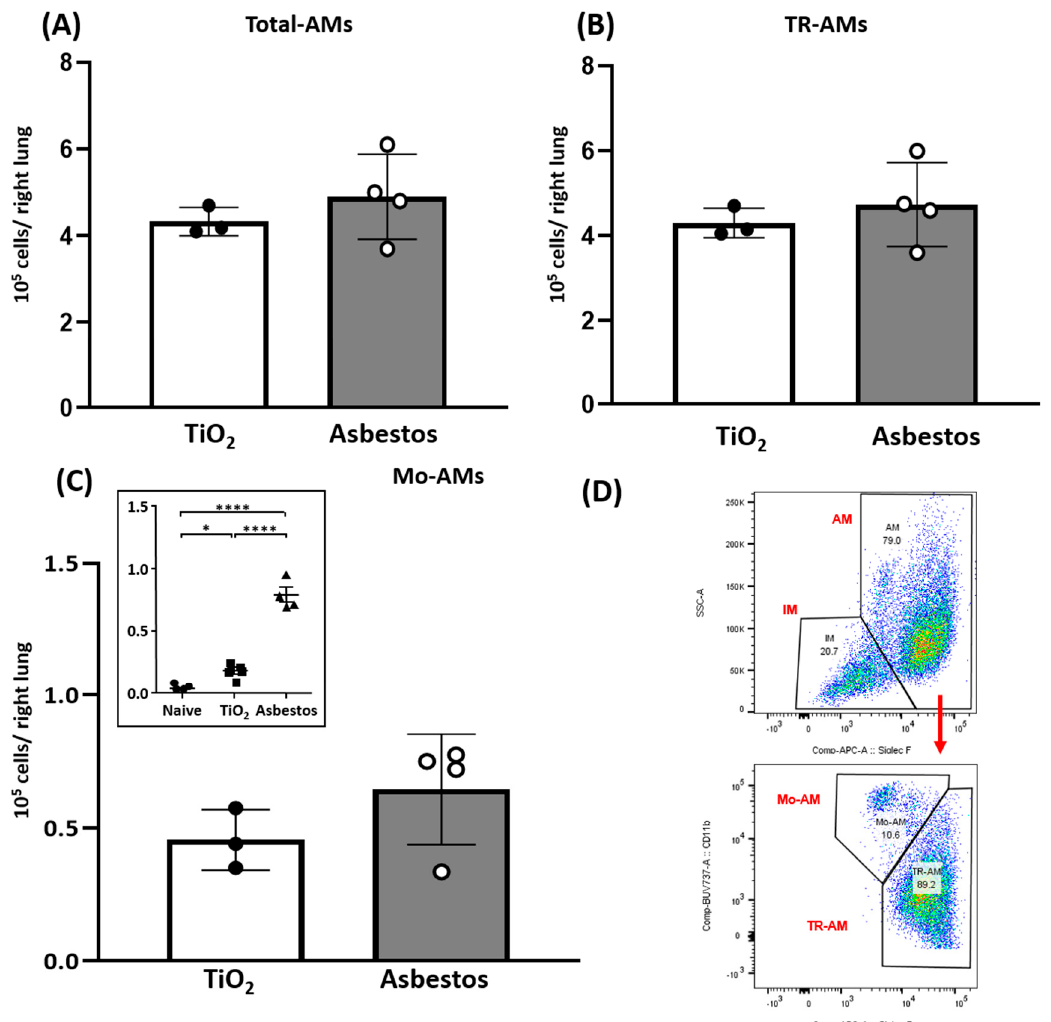
Figure 3. Sirt3 Tg mice do not recruit fibrogenic Mo-AMs to the lung following asbestos exposure. Sirt3 Tg mice were treated with TiO 2 or crocidolite asbestos (100 µ g in 50 µ L). Twenty-eight days after treatment, macrophages were purified from lungs and used for flow cytometry to determine recruitment of macrophage subsets, including profibrogenic monocyte-derived alveolar macrophages (Mo-AMs), as described in detail elsewhere (40), Lung cells were assessed for alveolar macrophages (( A ); AMs), tissue-resident macrophages (( B ); TR-AMs), and monocyte-derived alveolar macrophages (( C ); Mo-AMs) from the Sirt3 Tg lungs following TiO 2 or crocidolite asbestos exposure. For WT mice, Mo-AMs were assessed from the murine lungs following exposure to saline (naïve), TiO 2 , (open bars), or crocidolite asbestos (gray bars) and showed that asbestos induces ~3-fold increase in Mo-AMs as compared to controls (( C ) Insert). ( D ) Scatterplots showing fate distribution of AMs in mouse lungs, including relative percentage of Mo-AMs and TR-AMs. Please see Supplement Figure 2 for complete gating strategy. Statistics for insert: All data presented as mean ± SEM. One-way ANOVA with Tukey’s test for multiple comparisons; * p < 0.05, **** p < 0.0001. Insert figure reproduced with the permission of © ERS 2021: European Respiratory Journal 55 (1) 1900646; DOI: 10.1183/12993003.0646-2019 Published 16 January 2020 (Ref